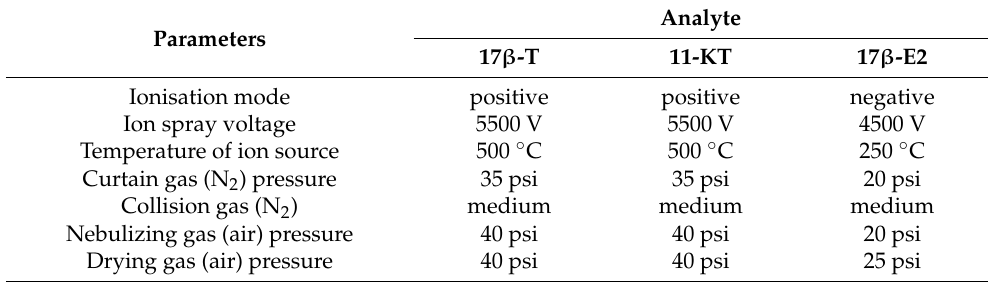
Table 2. Monitored ion of analytes and MRM parameters.